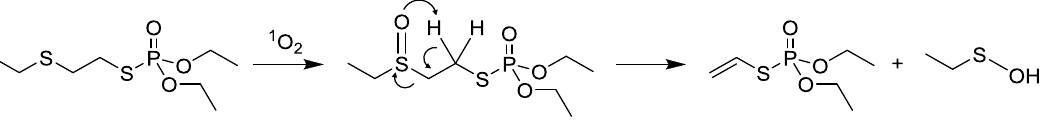
Figure 9. Proposed oxidation mechanism of Demeton- S and the formation of elimination product from photogenerated singlet